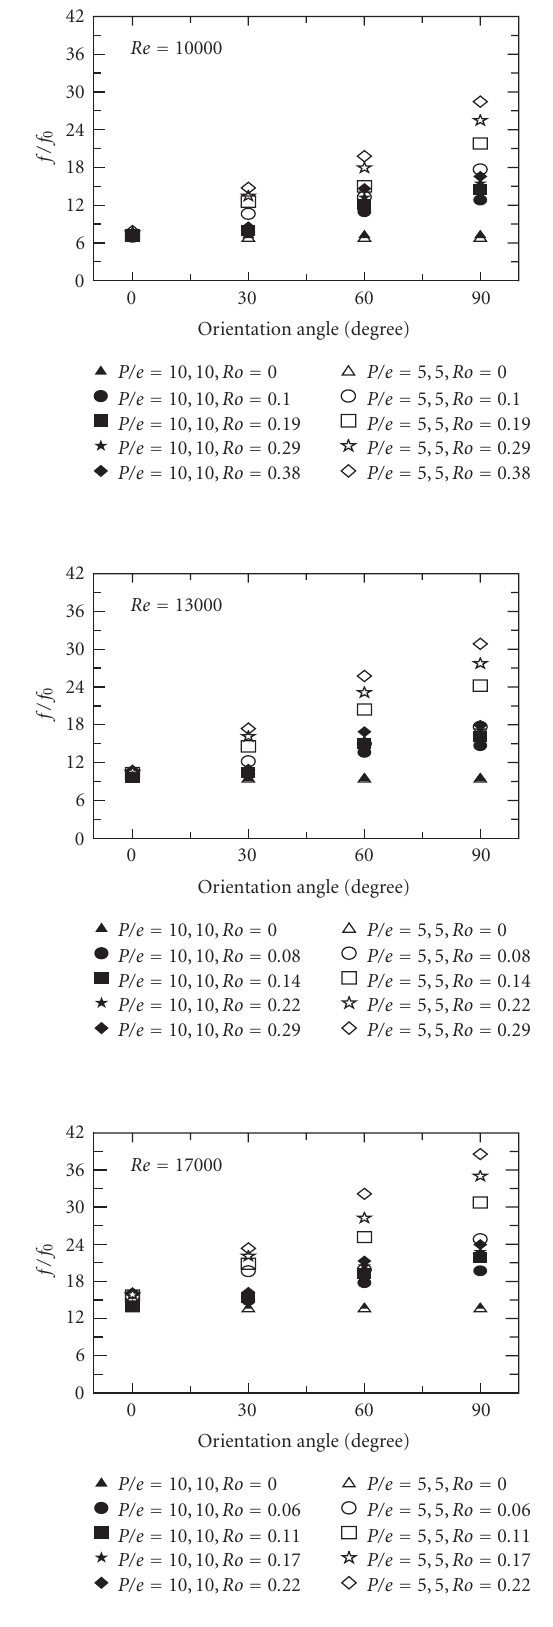
Figure 9: E ff ect of orientation angle in a rib-roughened square channel with detached ribs on two opposite walls.